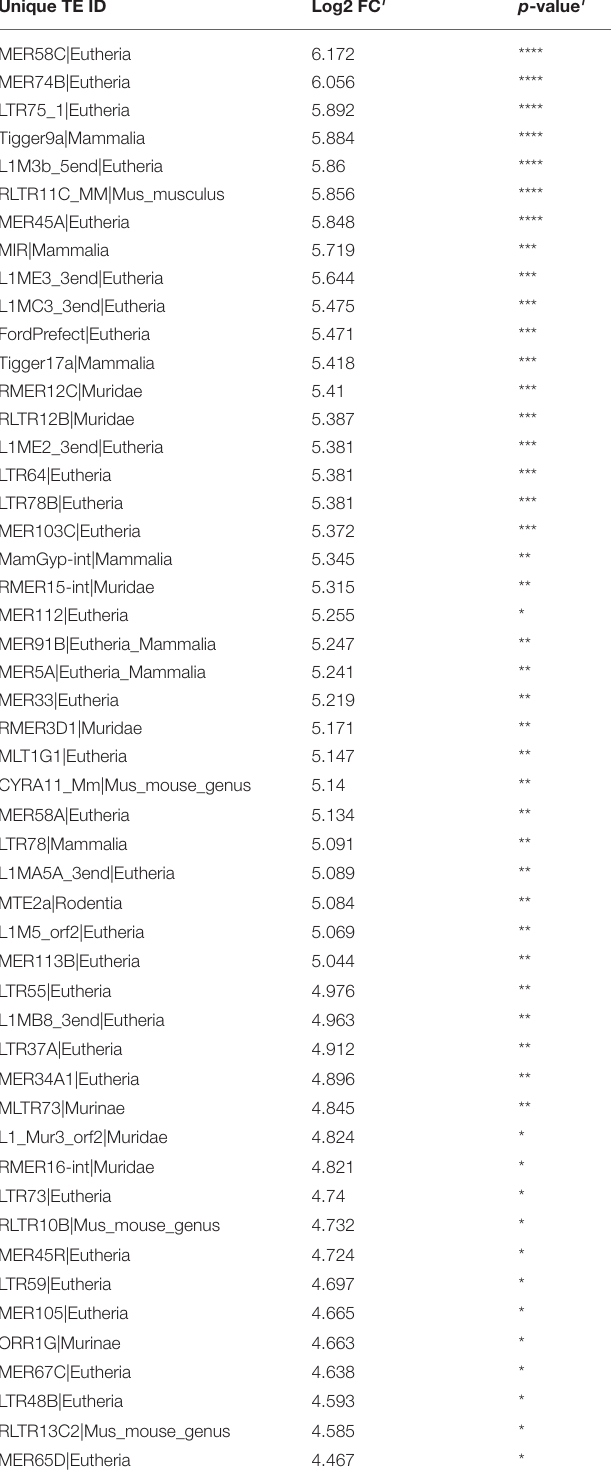
TABLE 2 | Gene-encoded, tumor-associated antigens significantly upregulated during transition from healthy pancreas (HP) to acinar-to-ductal metaplasia (ADM) and ADM to pancreatic ductal adenocarcinoma